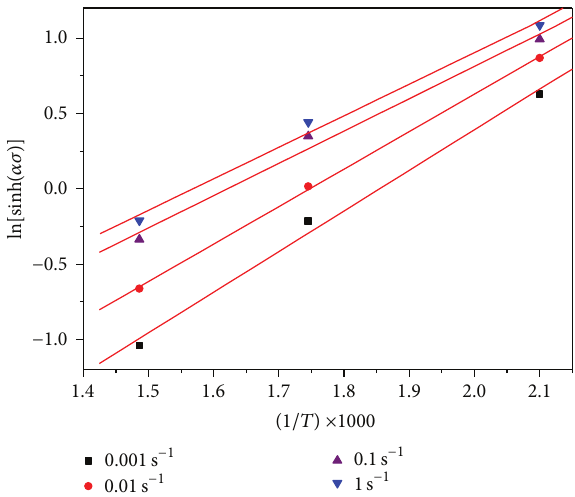
Figure 8: Relationship between flow stress and temperature of AZ81 magnesium alloy.